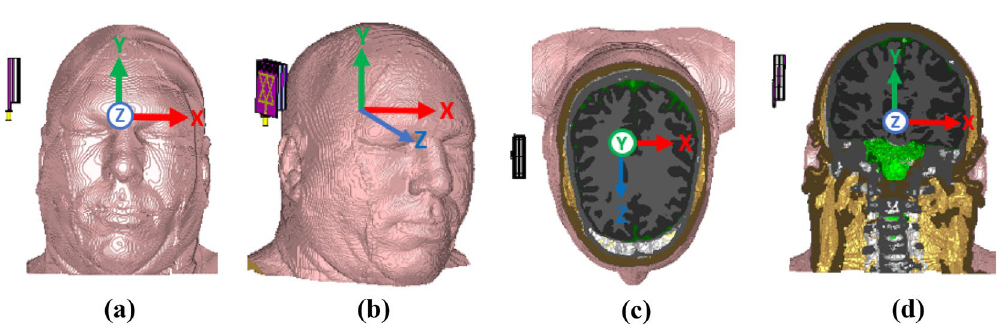
Figure 16. Different views and planes of Hugo Head model with a single antenna: ( a ) Front view; ( b ) Perspective view; ( c ) Transverse plane; ( d ) Coronal